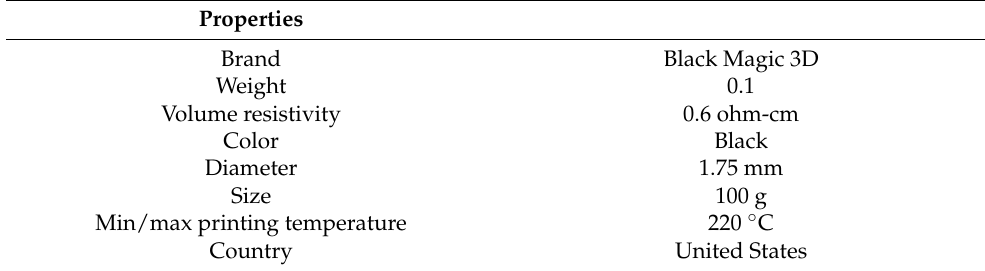
Table 2. Properties of 3D-conductive graphene composite filament [88].